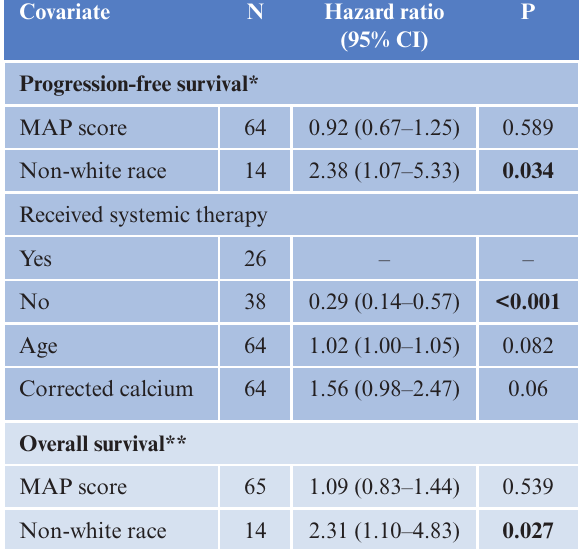
Table 3: Multivariable cox proportional hazard model for progression-free survival and overall survival in patients with the presence of an IVC tumor